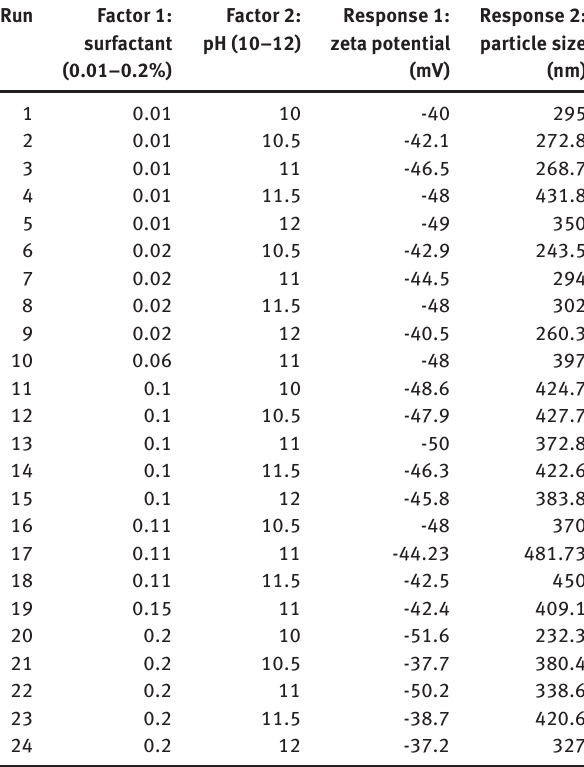
Table 1 Experimental results obtained from 24 independent runs for TiO nanofluid. 2